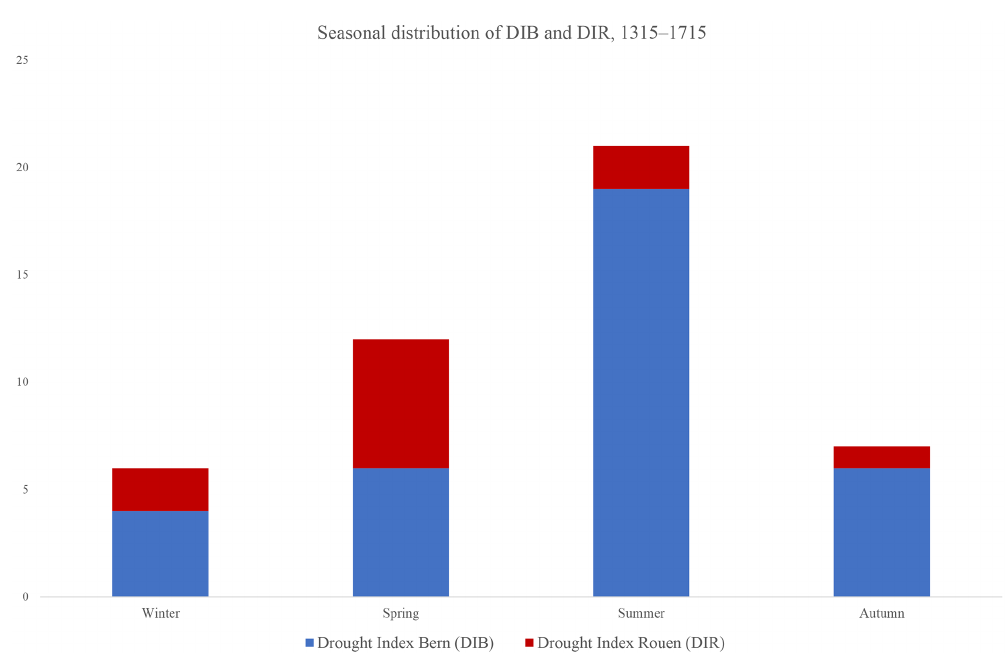
Figure 2. Seasonal distribution of drought index of Bern (DIB) and drought index of Rouen (DIR), 1315–1715.